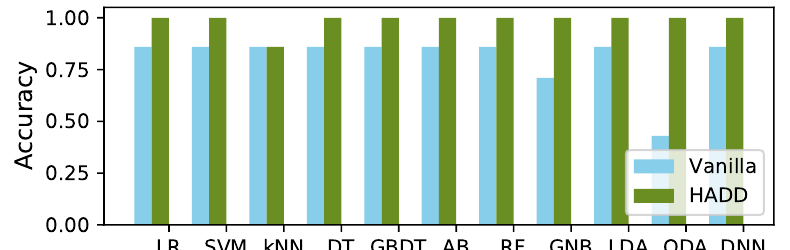
Figure 3. Accuracy of HADD and the vanilla state-of-the-art ML methods that do not exploit the feature selection, data augmentation, or two-stage detection techniques supported by HADD. Instead, they used all features, performed no data augmentation, and detected depressed mood in a single stage by using trained ML models